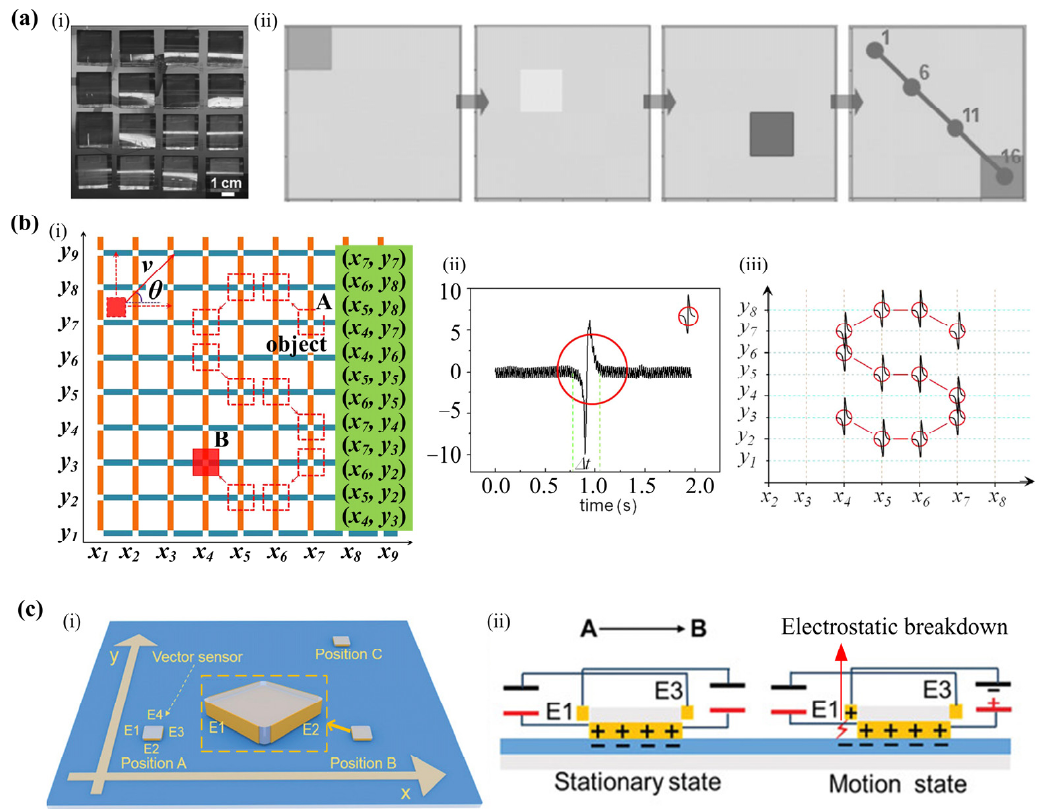
Figure 14. ( a ) ( i ) Image of the sensor array including 16 TENGs, ( ii ) the produced mapping images when an object moves along “1 → 6 → 11 → 16” (Reproduced with permission [96]. Copyright 2013 trajectory tracking sensor array in which the trajectory of the object is from A to B, ( ii ) the current pulse signal from an output port versus time, ( iii ) the current pulse signal from both x and y